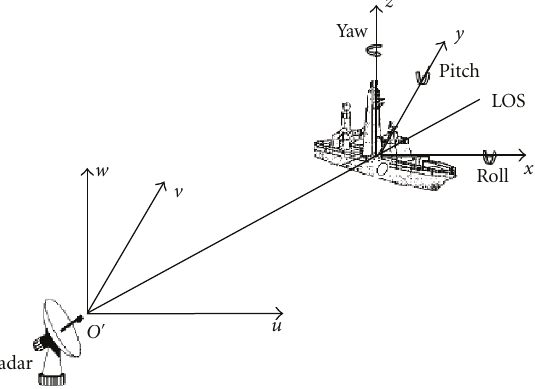
Table 2: Simulation